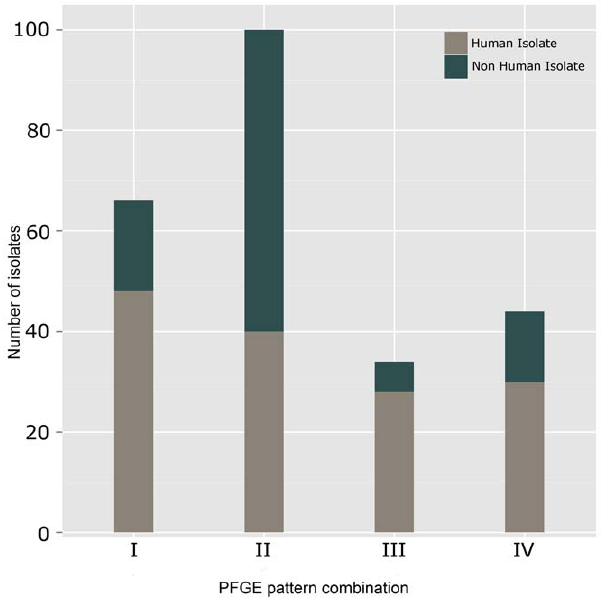
Figure 2. Distribution of Listeria monocytogenes isolates pro- ducing PFGE pattern combinations. I- IV from human (grey) or nonhuman (green) sources. Only isolates from August 25–November 15, 2011 (duration of the outbreak) are included.